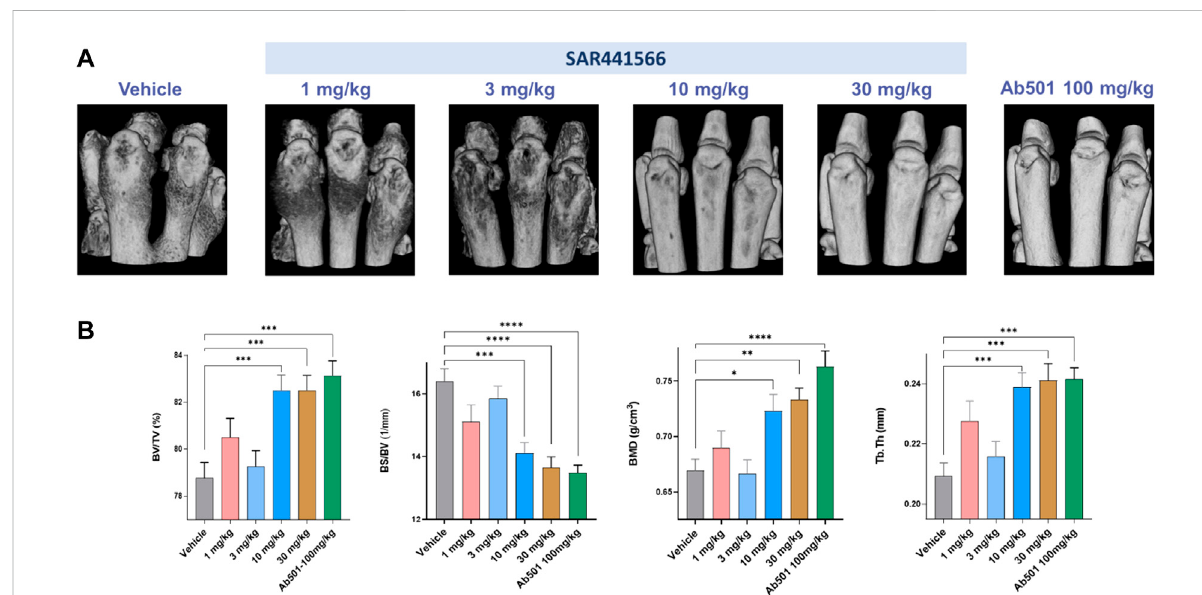
FIGURE 4 Effect of SAR441566 on bone in the CIA model as assessed by 3D volumetric micro-computed tomography: (A) shows a representative 3D renderingviewofhind pawsfromanimalstreatedtherapeuticallywithSAR441566. Adose-dependenttrendfor boneimprovement withSAR441566 is observed and at a dose of 10 and 30 mg/kg these effects are comparable to those seen in the Ab501 treated group. (B) 3D volumetric analysis of whole bone microstructure, using the trabecular bone analysis methods and parameters, of the hind paws with a dose-dependent trend for SAR441566 on bone volume fraction (BV/TV), bone surface density (BS/BV), bone mineral density (BMD), and bone fragment thickness (Tb.Th) reachinganti-TNFbiologic-likeeffectsat10and30mg/kg,respectively.Statisticalanalysis wasperformedusingtheone-wayANOVAandDunnett ’ s multiple comparisons test, * for p < 0.05; ** for p < 0.005; *** for p < 0.001; and **** for p < 0.0001.